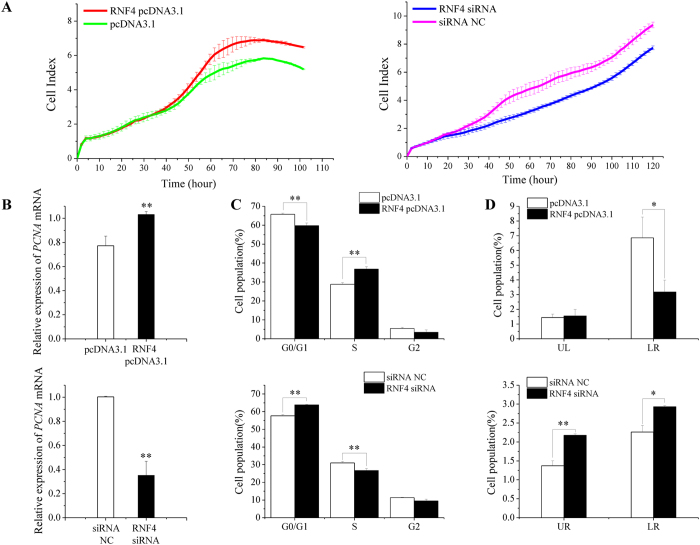
RNF4 promotes ST cell proliferation and inhibits apoptosis.ST cells were transfected with RNF4 pcDNA3.1 or pcDNA3.1 and RNF4 siRNA or siRNA NC. (A) Cell growth dynamics were continuously monitored by the xCELLigence system. (B) The PCNA mRNA levels were detected in ST cells 24 h after transfection. (C) Cell cycle phase was analysed 48 h after transfection by propidium iodide flow cytometry. (D) Cell apoptosis was measured 48 h after transfection using Annexin-V/PI staining, followed by flow cytometer analysis. UR: late apoptosis, LR: early apoptosis. **P < 0.01, *P < 0.05.